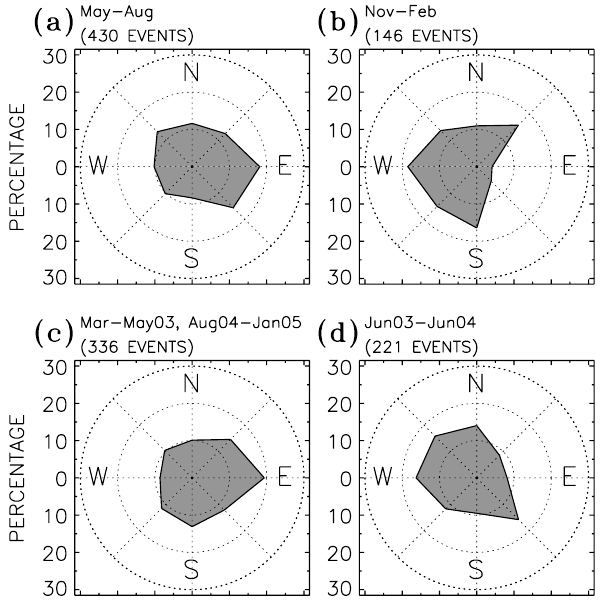
Fig. 3. Seasonal variations in the horizontal propagation directions of the gravity waves: (a) May–August and (b) November–February. The scale indicates the fraction (in percent) of gravity waves prop- agating in each direction. The bottom panels show the horizon- tal propagation directions during (c) March–May 2003 and August 2004 to January 2005 and (d) June 2003 to June 2004, coinciding with the westward and eastward phases of the QBO, respectively.